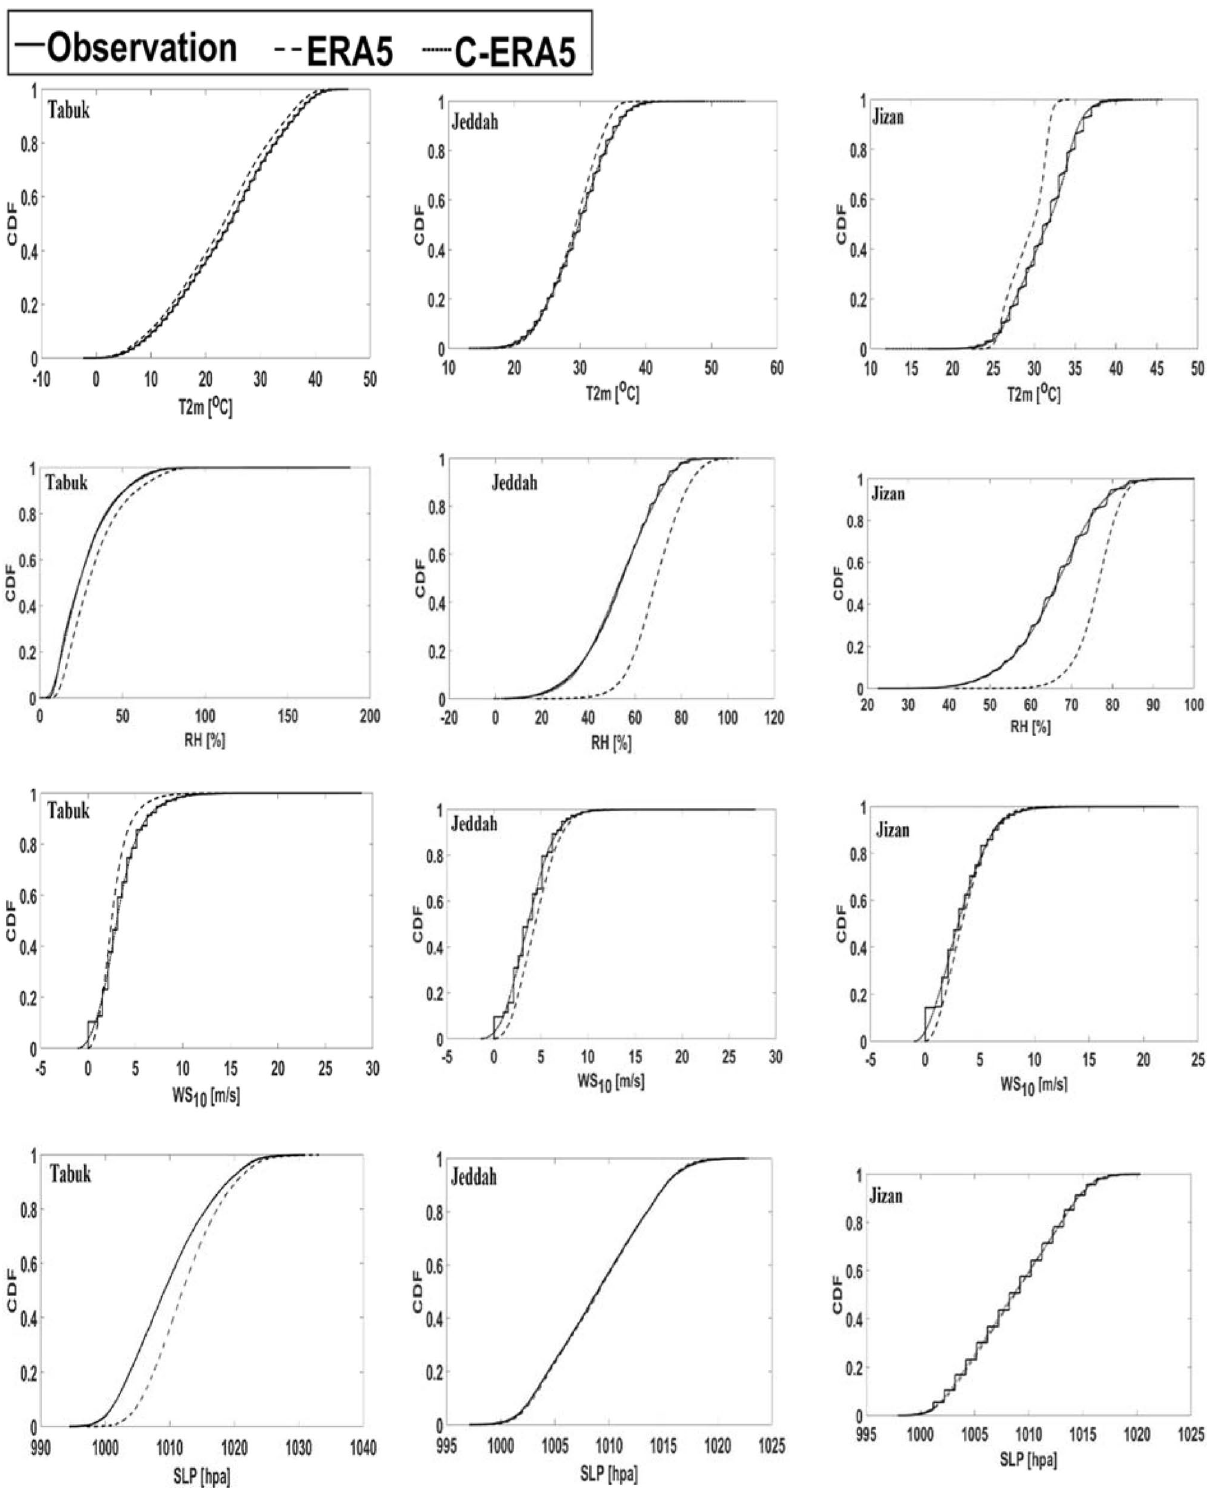
Figure 9. Cumulative distribution function (CDF) between the observations and ERA5 data from 2016–2020 for T2m (2-m air temperature), RH (relative humidity), surface wind speed (WS 10 ), and SLP (mean sea level pressure). The corrected ERA5 (C_ERA5) curves are identical to the observed curves. Math Works, Inc. MATLAB. Version 2020a, Math Works, Inc., 2020. www. mathw orks.